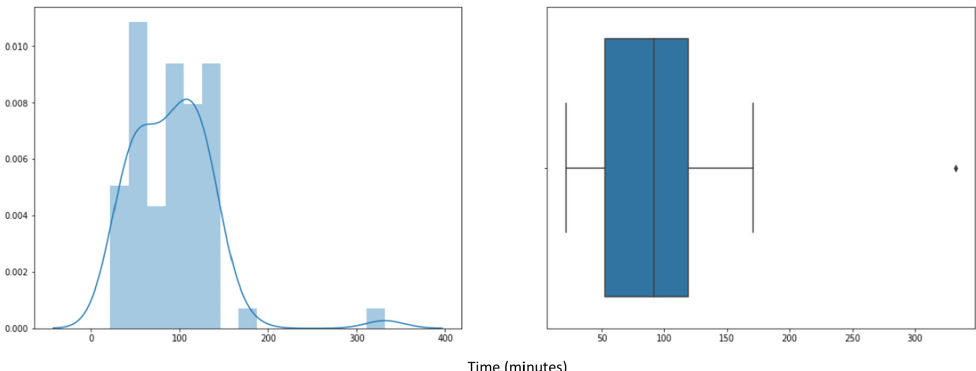
Figure 10. Distribution of preheating completion times for 200 product batches: histogram ( left ); box plot ( right ).